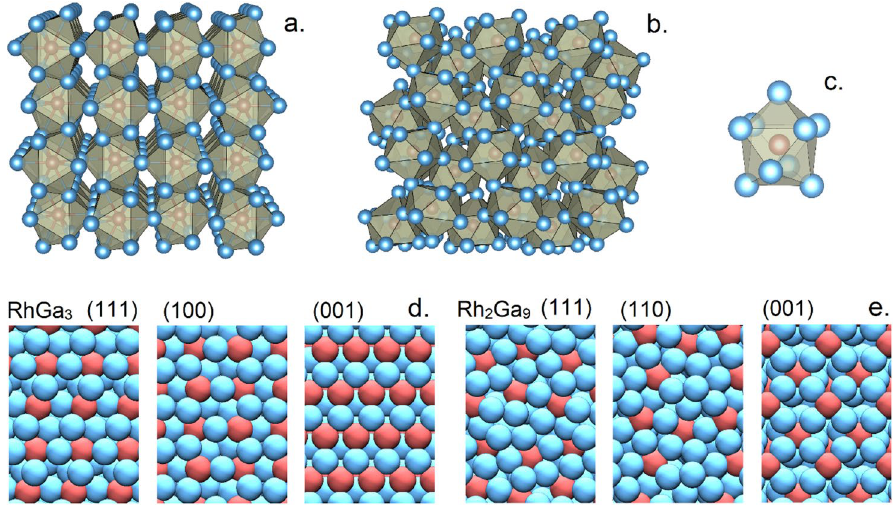
Figure 2. ( a ) Ga 3 Rh structure ( b ) Ga 9 Rh 2 structure. Both structures are networks of Ga 9 Rh polyhedra; for comparison one polyhedron is shown in ( c ). In ( d ) and ( e ) the three most stable Ga 3 Rh and Ga 9 Rh 2 surfaces identified by DFT are depicted. (Ga is shown in blue, Rh in red. The green polyhedra are a guide to the eye).